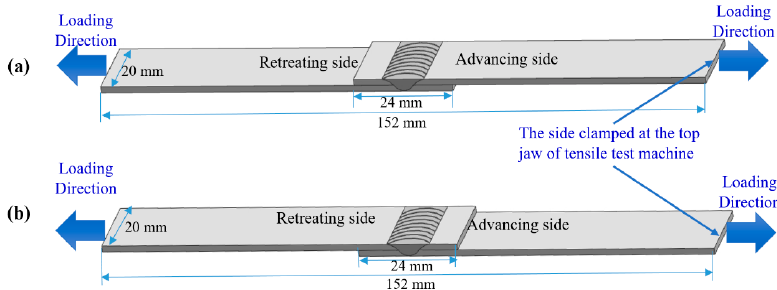
Figure 3. The schematic and dimensions of the weld coupons to make the tensile test. ( a ) Configuration No. 1, when the advancing side is on the upper sheet; ( b ) Configuration No. 2, when the retreating side is on the upper sheet.